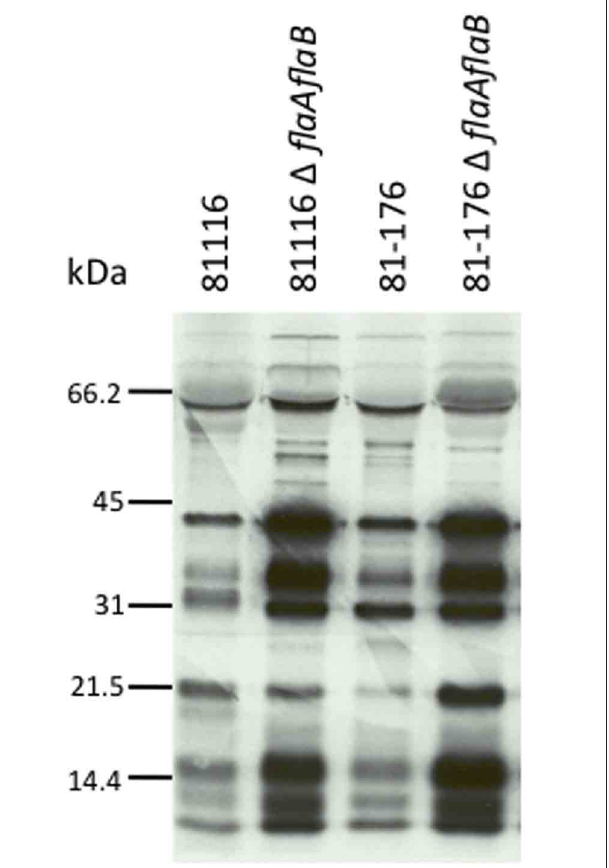
FIGURE A2 | C. jejuni 81116 and 81–176 flaAflaB mutants secrete the Cia proteins. Secretion of the Cia proteins from 81116 and 81–176 wild-type strains and isogenic flaAflaB mutants was stimulated by incubation with 1% FBS, and the secreted proteins were analyzed by autoradiograph.